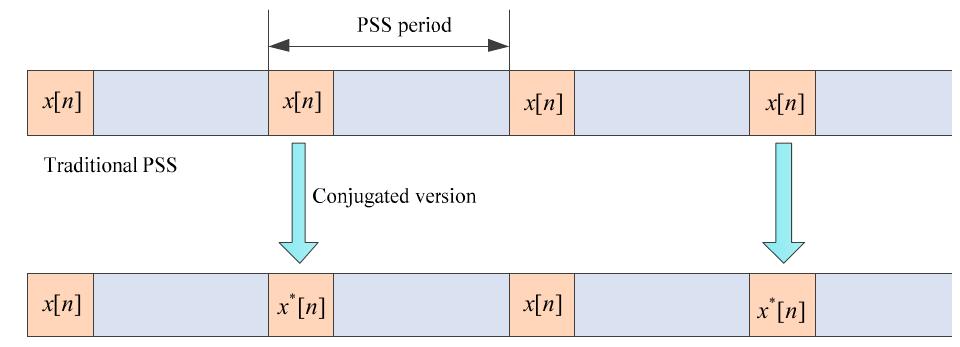
Figure 1. Illustration of our proposed conjugated-sequences-based primary synchronization signal (PSS) structure.